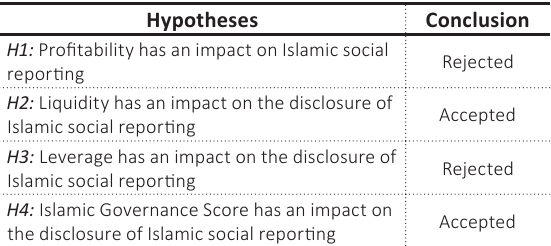
Table 3. Hypotheses acceptance or